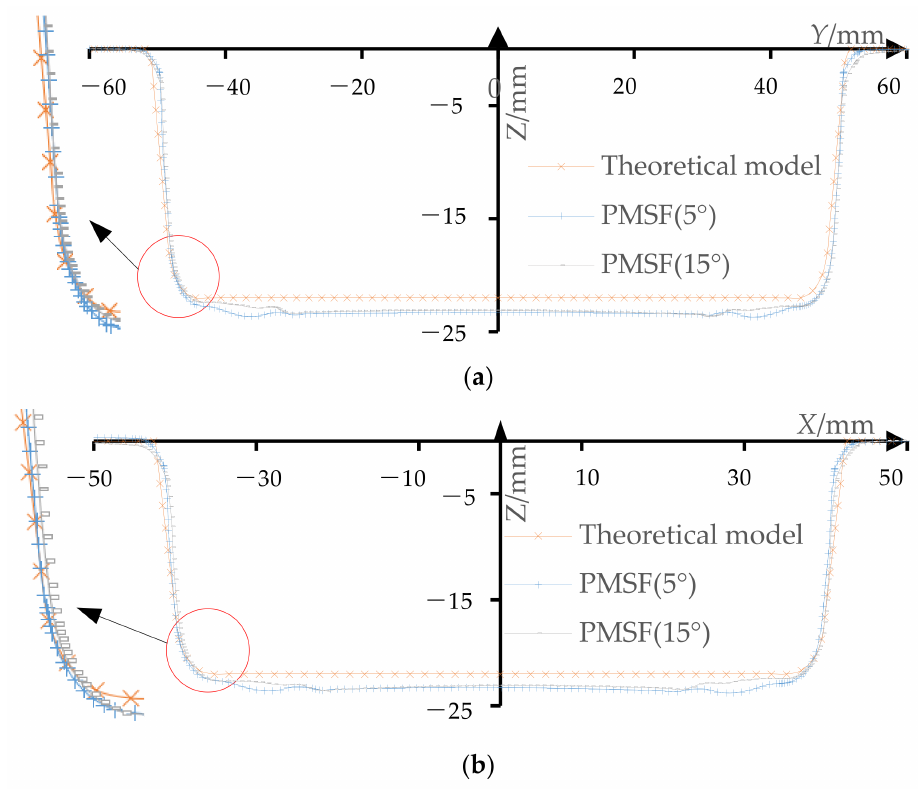
Figure 21. The profile curve: ( a ) the section of the long axis and ( b ) the section of the short axis. In order to compare and analyze the influence of two different stretching angles ( ψ = 5 ◦ and ψ = 15 ◦ ) on the dimensional accuracy of the profile of the formed part, the Z direction deviation of the profile of the section with the long axis (Figure 22a) and the Z direction deviation of the section with the short axis (Figure 22b) are drawn.